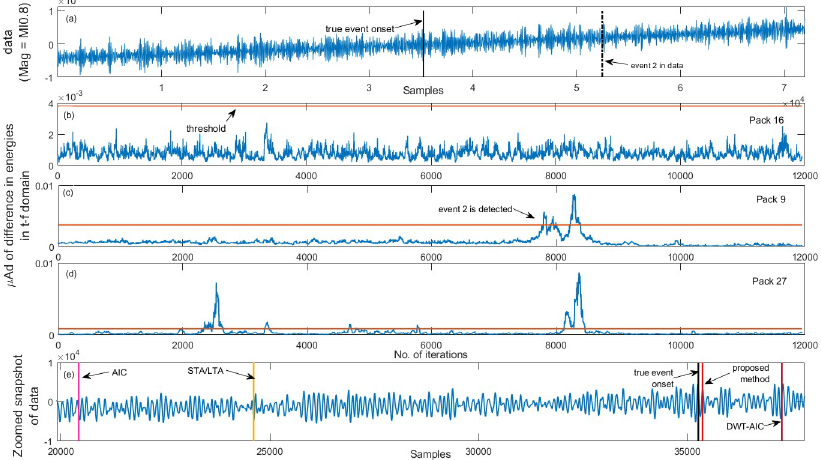
Fig 12. Low magnitude event detection results. Vertical channel TSUM station (a) data with two events—solid vertical black line indicates the true onset of the seismic event of interest and the dashed black color line indicates the second event in the data. Plots (b), (c) and (d) depict the μ AD corresponding to packets 9, 16 and 27 respectively and plot (e) is a zoomed snapshot of data—the red vertical line indicate the time at which the proposed algorithm picks the low magnitude